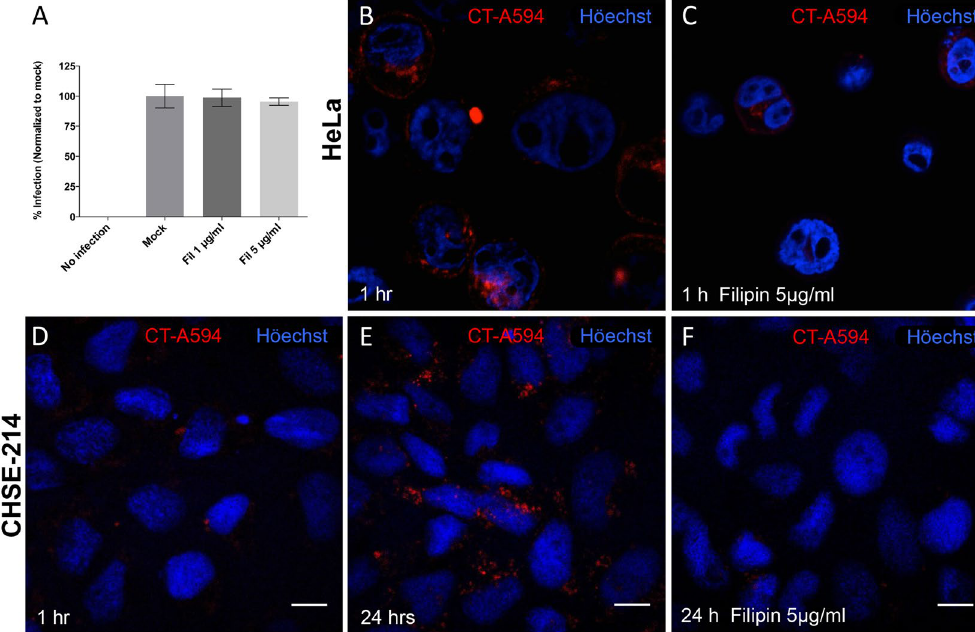
Figure 3. Filipin does not affect IPNV infection of CHSE-214 cells. CHSE-214 cells were infected with IPNV at an MOI of 1 for 1 h with 1 or 5 μ g/ml of filipin (Fil). After 12 h of incubation at 20°, cells were processed by indirect immunofluorescence (IFI) for IPNV VP2/VP3. Images were recorded with an Olympus Spinning Disk IX81 microscope. For each condition, 250 cells were counted. Number of VP2/VP3-expressing cells is shown as a percentage, normalized to mock cells ( A ). Control HeLa cells were pre-incubated for 1 h with 0 ( B ) or 5 μ g/ ml ( C ) filipin and 2.5 μ g/ml Alexa Fluor 594-conjugated cholera toxin B (CTB-A594) subunit were added. After 30 min, cells were processed for confocal fluorescence microscopy. CHSE-214 cells were preincubated 1 h in the absence ( D , E ) or with 5 μ g/ml filipin ( F ). CTB-A594 (2.5 μ g/ml) was added and cells were incubated for